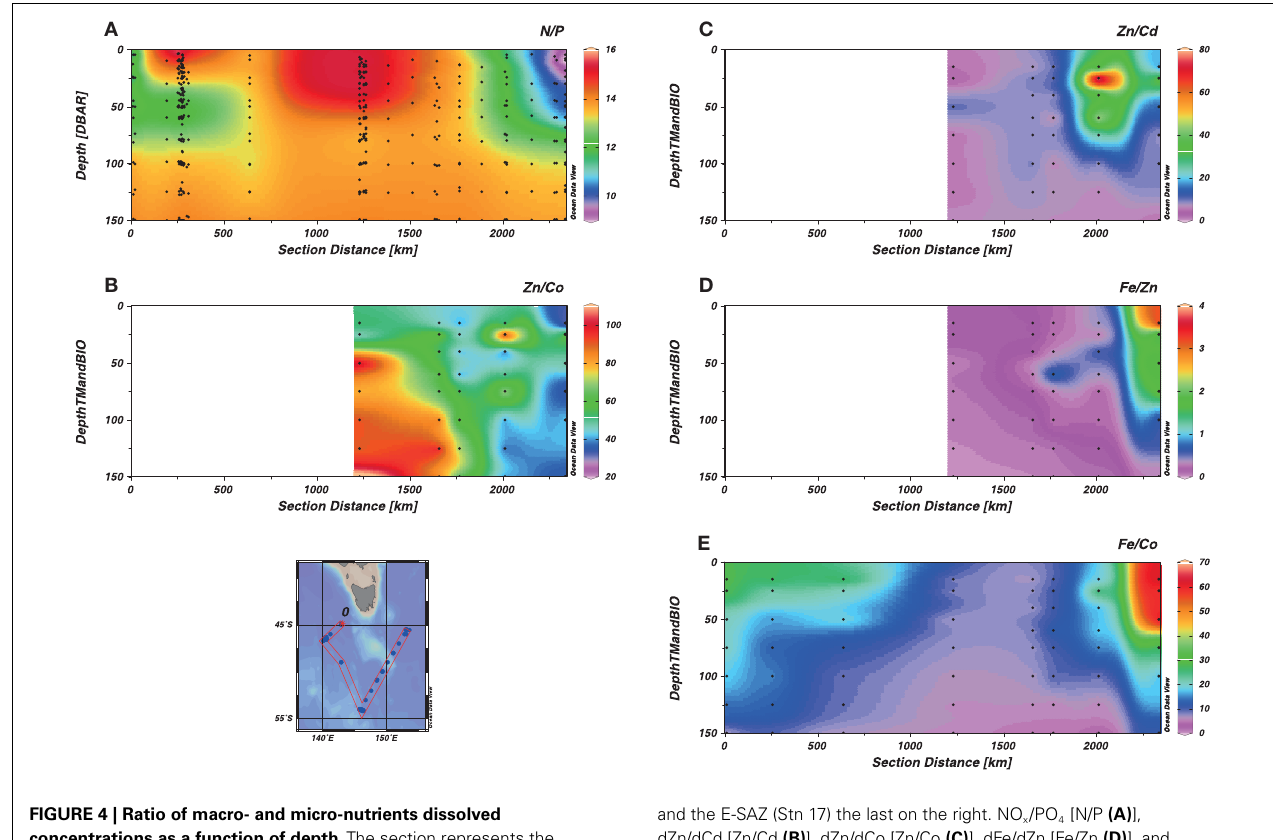
FIGURE 4 | Ratio of macro- and micro-nutrients dissolved concentrations as a function of depth. The section represents the whole voyage track from Stn 2 to Stn 17, with theW-SAZ (Stn 4) being the second station on the left, the PFZ (Stn 6) in the center